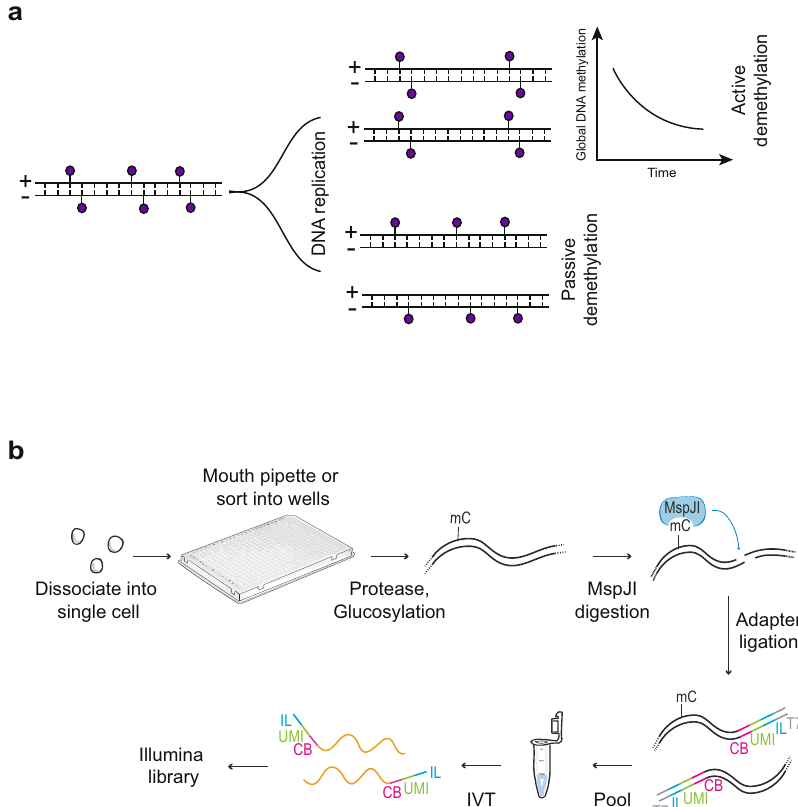
Fig. 1 Schematic of scMspJI-seq. a DNA methylation maintenance can be probed using strand-speci fi c quanti fi cation of 5mC in single cells. Cells displaying symmetric levels of 5mCpG on both DNA strands of a chromosome coupled with a global temporal loss of 5mCpG indicates active demethylation, whereas loss of methylation maintenance with asymmetric levels of 5mCpG between the two DNA strands indicates passive demethylation. b Single cells isolated by FACS or manual pipetting are deposited into 384-well plates and lysed. Following protease treatment to strip off chromatin and blocking of 5hmC sites by glucosylation, MspJI is used to recognize 5mC sites and cut gDNA 16 bp downstream of the methylated cytosine. After ligating double-stranded adapters — containing a cell-speci fi c barcode (CB, pink), a random 3 bp unique molecule identi fi er to label individual 5mC sites on different alleles (UMI, green), 5 ′ Illumina adapter (IL, blue) and T7 promoter (T7, gray) — to the fragmented gDNA, molecules from all single cells are pooled and ampli fi ed by in vitro transcription. The ampli fi ed RNA molecules are used to prepare scMspJI-seq libraries and sequenced on an Illumina